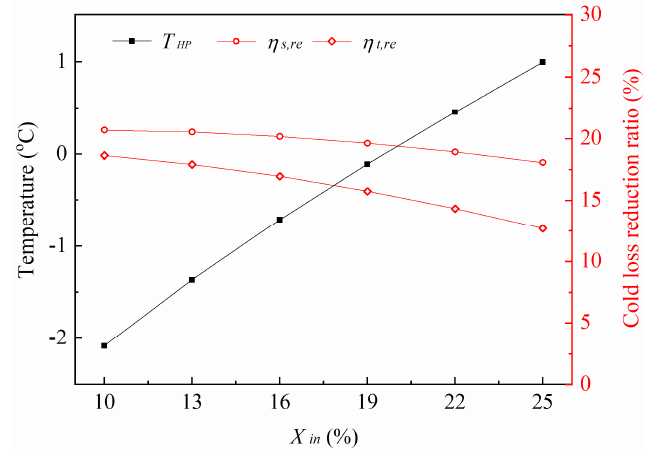
Figure 14. Temperatures of heat pipes and cold reduction ratios of side and topside freezer walls at various X in .